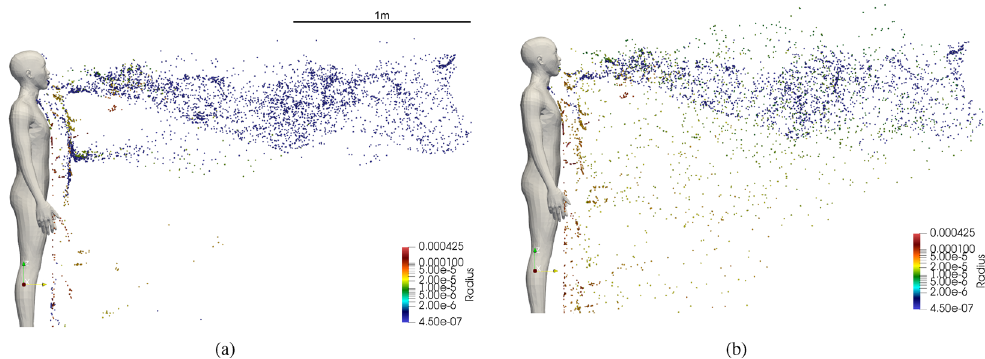
Figure 10. A snapshot of droplet dispersion at t = 24 s for ( a ) RH = 50% ( b ) RH = 100% .